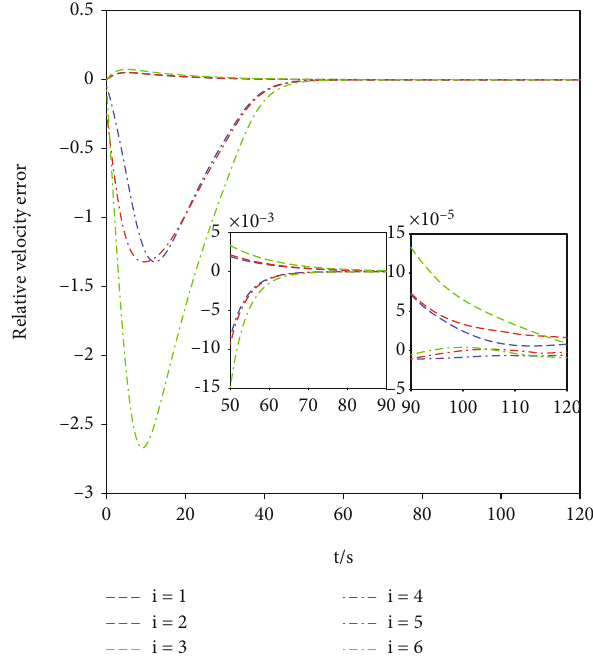
Figure 5: Relative velocity error